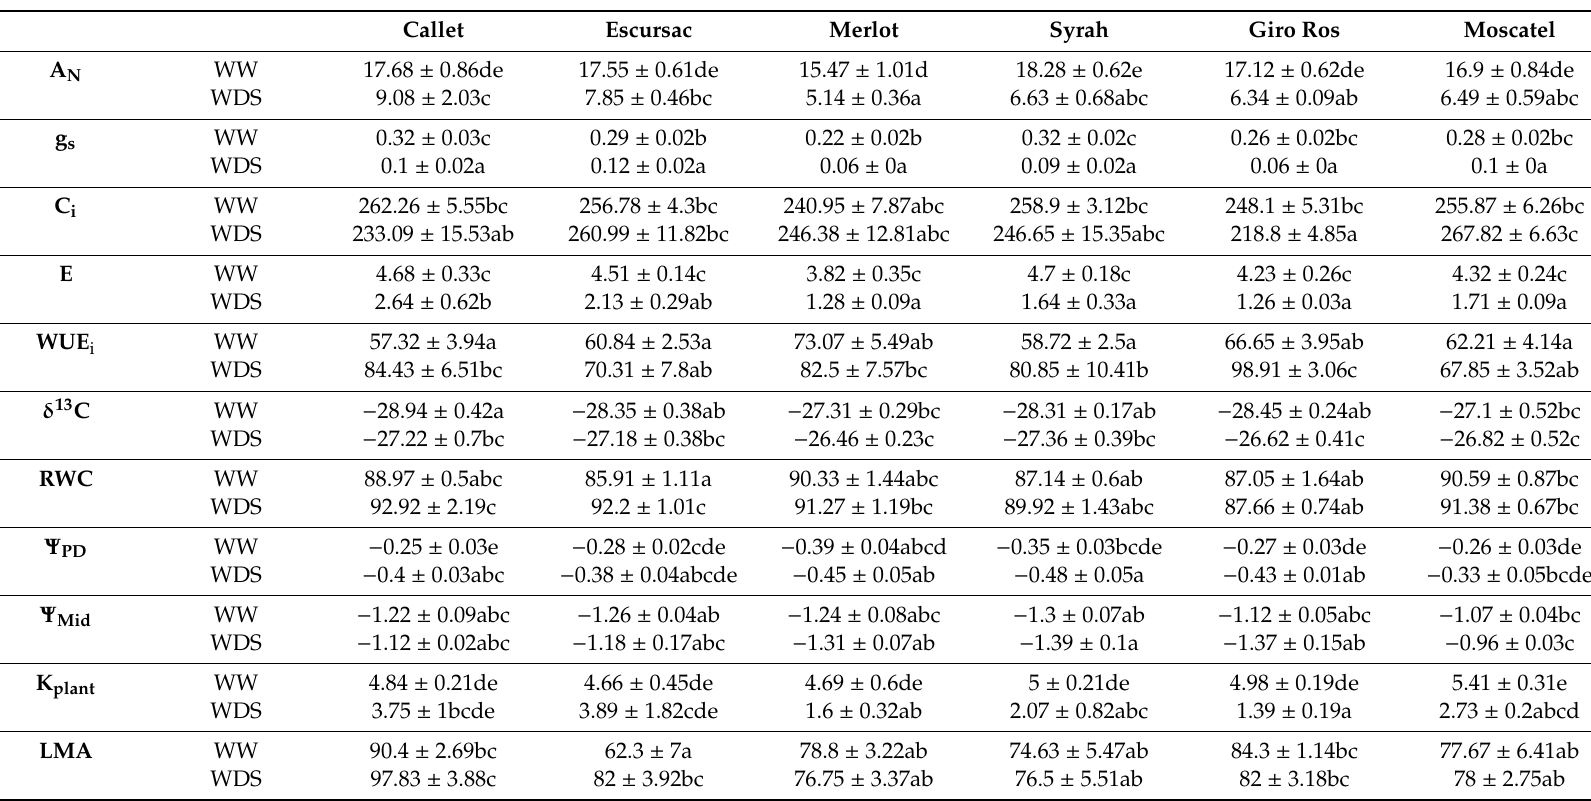
Table 1. Physiological and anatomical parameters in all grapevine cultivars under well-watered (WW) and water deficit stress (WDS). Data is presented as means ± SE for three to six replicates. Di ff erent letters denote significant ( p < 0.05) di ff erences between treatments and cultivars by Duncan test.